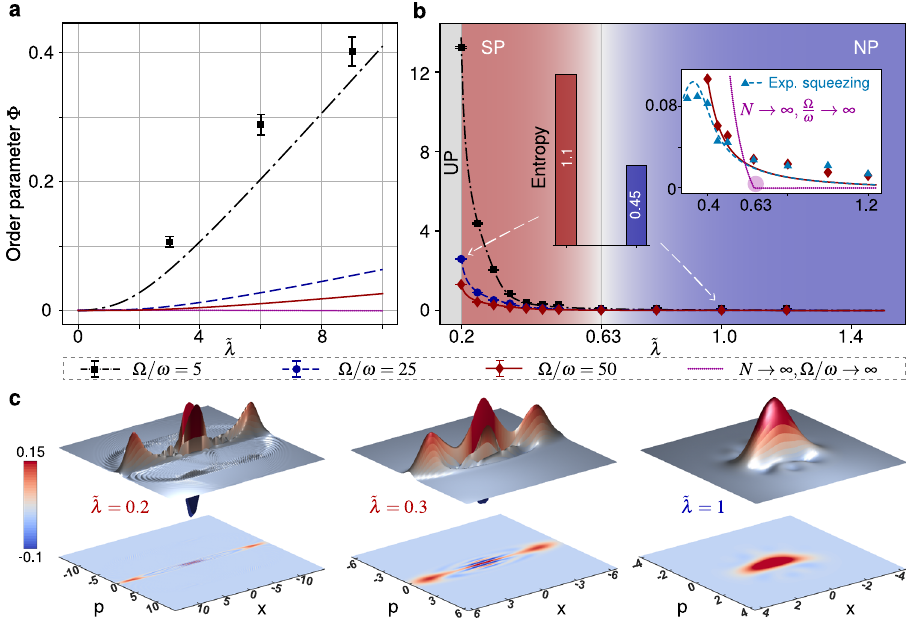
Fig. 3 Experimental demonstration of the recovering of equilibrium SPT induced by the antisqueezing effect. a, b The order parameter Φ versus the scaled spin- fi eld coupling strength ~ λ for a ξ = 0 and for b ξ / ω = 0.26. The inset plot of b shows the comparison between the cases of fi nite-parameter ( Ω / ω = 50) and the classical oscillator limit ( Ω / ω → ∞ , the SPT occurs exactly). The red solid line (blue dotted line) represents the order parameter Φ on ~ λ without (with) the experimental implementation of the squeezing operation. The shading of b divides normal phase (NP) and superradiant phase (SP) q ffiffiffiffiffiffiffiffiffiffiffiffiffiffiffiffiffiffiffiffiffiffiffiffiffiffiffiffiffiffiffi . The system is in unstable phase (UP) when the rescaled ground-state excitation becomes an according to the exact critical point ~ λ ¼ 1 þ α ~ λ 2 (cid:2) 4 ξ = ω ffiffiffiffiffiffiffiffiffiffiffiffiffiffiffiffiffiffiffiffiffiffiffiffiffiffiffiffiffiffiffiffi p imaginary number, i.e., ~ λ < ð 1 = α Þð 4 ξ = ω (cid:2) 1 Þ . The bar graphs of b indicate two von Neumann entropies of system in SP ( ~ λ ¼ 0 : 2) and NP ( ~ λ ¼ 1) when Ω / ω = 25. c , The corresponding Wigner functions of experimentally prepared ground states for ~ λ ¼ 0 : 2 ; 0 : 3 (SP) and ~ λ ¼ 1(NP) when Ω / ω = 25. Here α = 1.1 for all fi